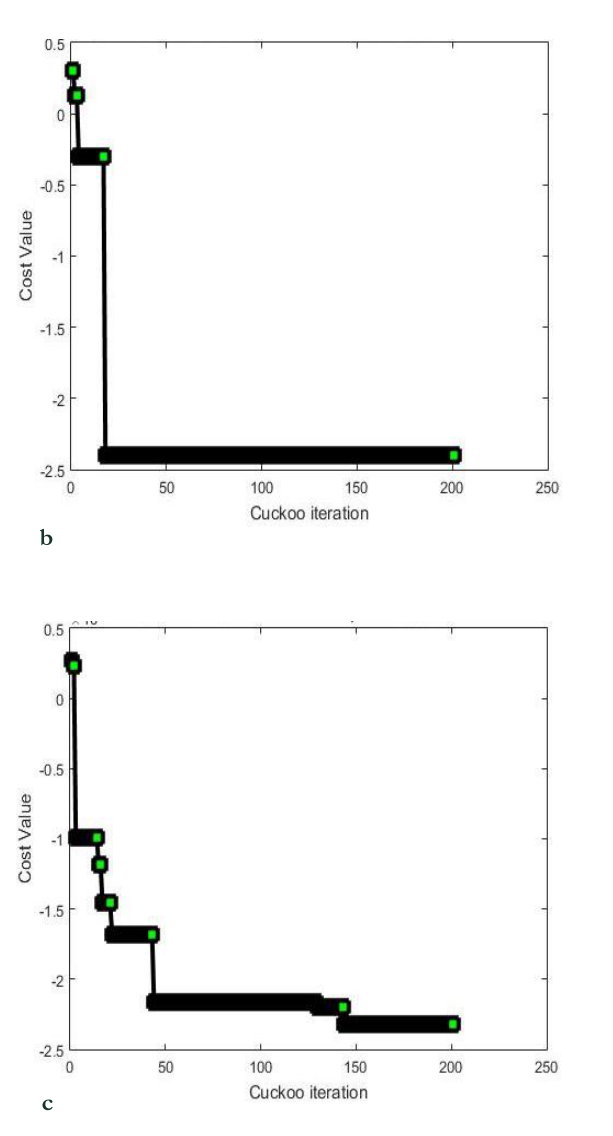
Fig. 6. The effect of changing the number of clusters on the value of the integration function: (a) The number of clusters=4 , (b) the number of clusters=3, the number of clusters=2.